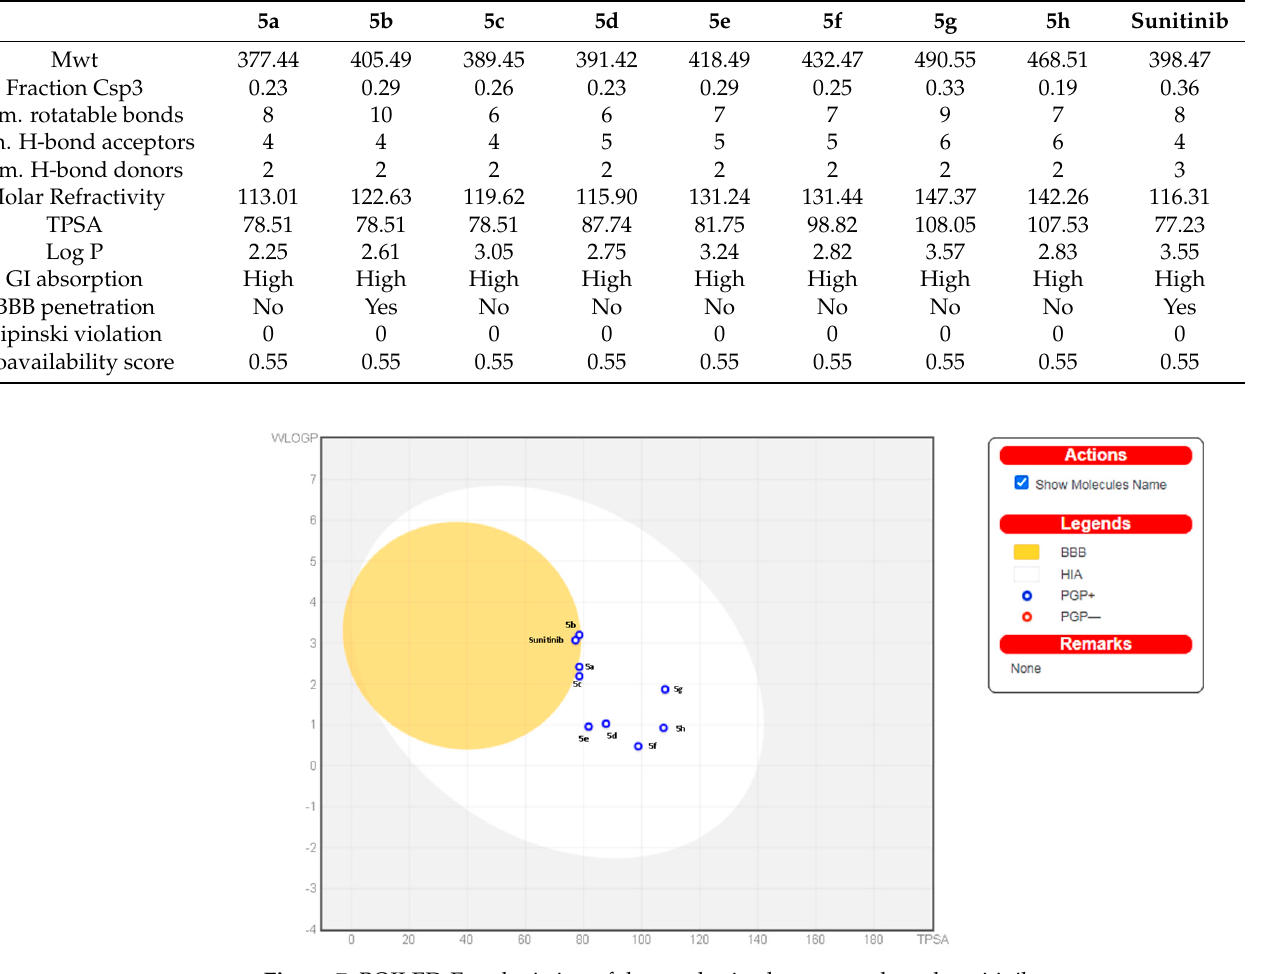
Table 4. Physicochemical properties of the synthesized compounds 5a – h compared to sunitinib.